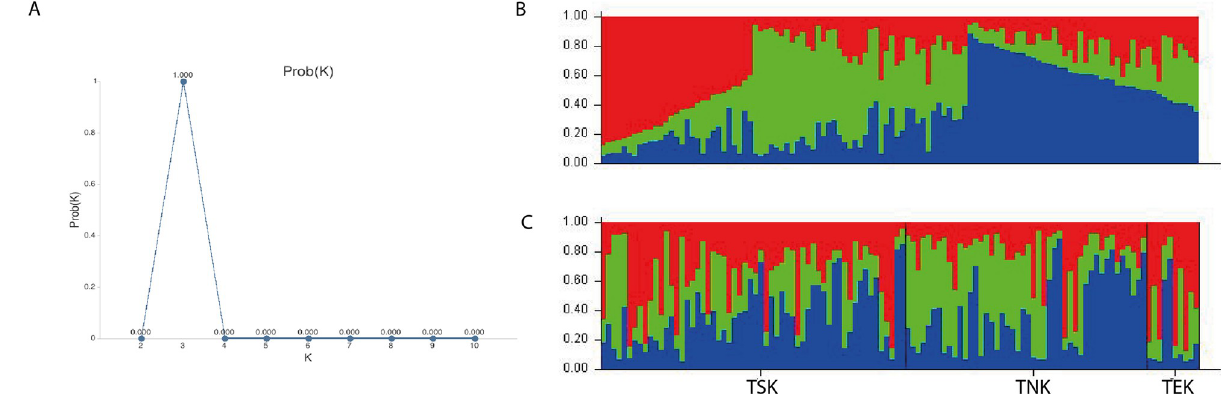
Fig 1. Genetic structure of the Tazy subpopulations. Bayesian clustering on the STR dataset of 114 dogs performed with STRUCTURE v2.3.4 after correction by Evanno et al. (CLUMPAK): A- Delta K results; B and C- bar plots where each dog accession is represented by a single vertical line, and this line shows colored segments representing the relative percentage of membership in the K cluster. B—bar plot grouped by clusters; C—bar plot grouped by subpopulations. Abbreviations of subpopulations: TSK—Tazy of South Kazakhstan, TNK—Tazy of Northern Kazakhstan, T Е K—Tazy of Eastern Kazakhstan.